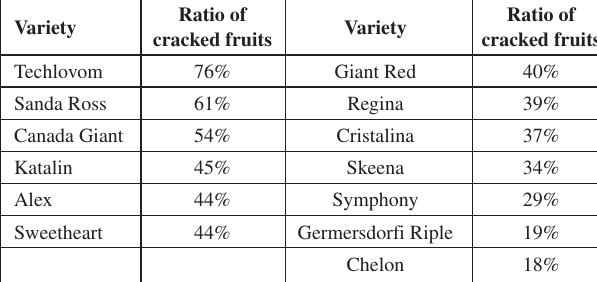
Table 1. Fruit cracking of sweet cherry varieties, Nagykutas (Source: consortium report 2009) Ratio of Variety